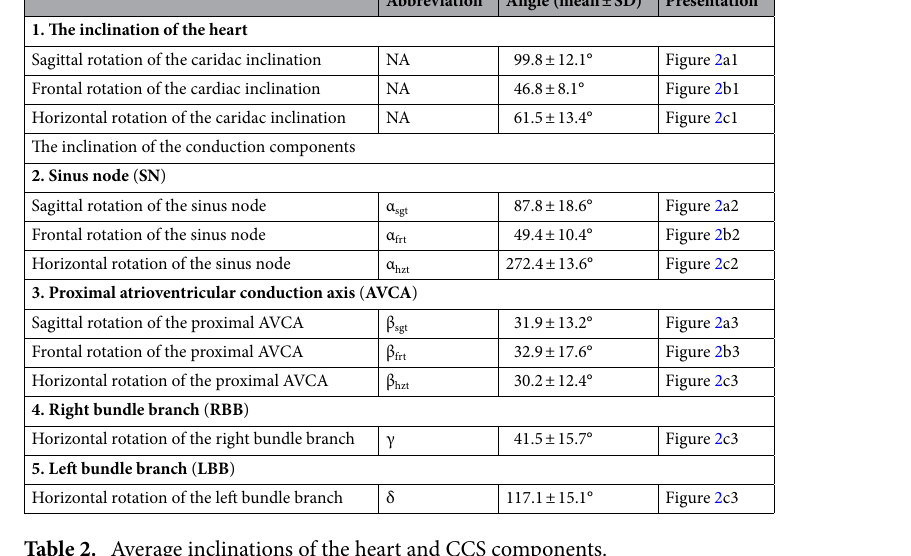
Table 2. Average inclinations of the heart and CCS